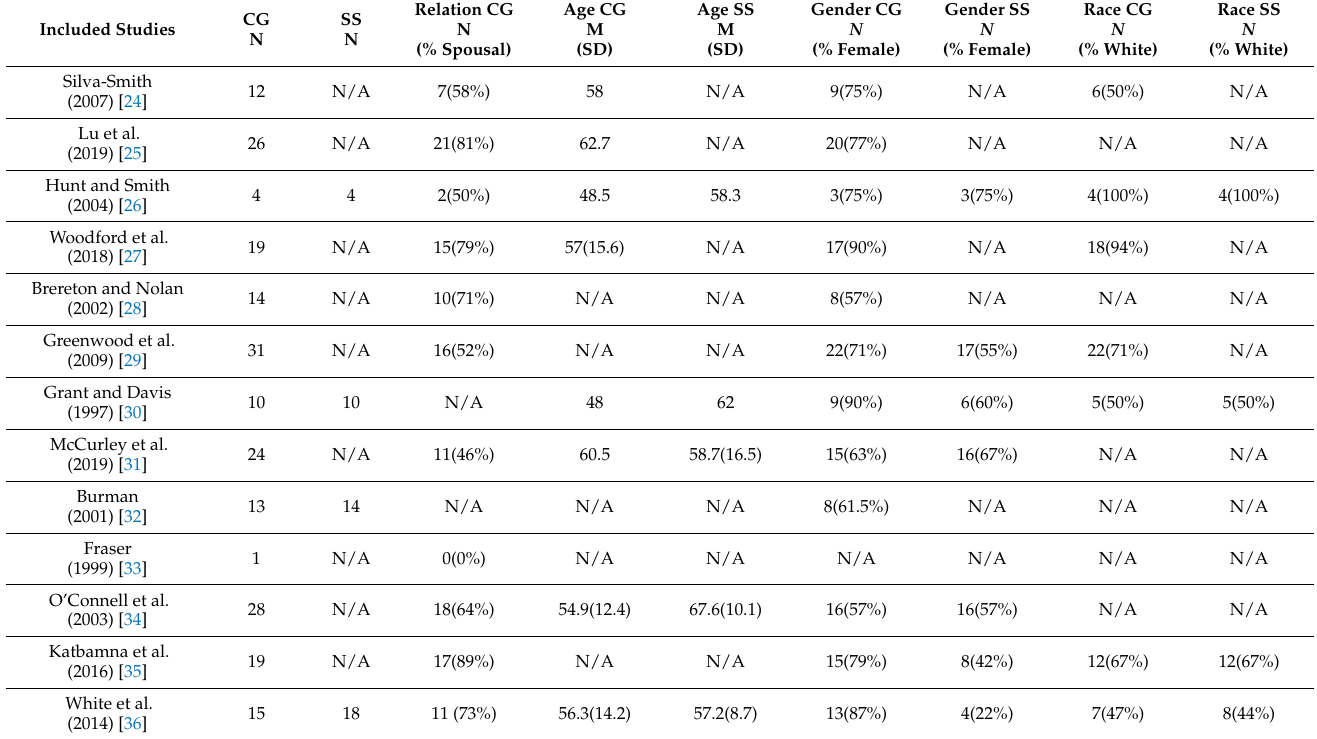
Table 1. Study demographics.